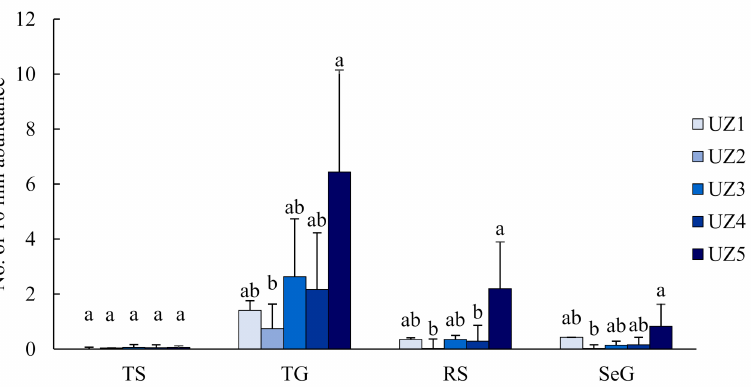
Figure A2. Changes of observed 10-min butterfly abundance in different groups along the urban- isation gradient (UZ1, urban centre; UZ5, urban fringe). Different letters above the bars indicate significant differences at p < 0.05. Table A1. List of the 28 sampling urban parks in the study. Urban zones represent the location of the park (UZ1, urban core; UZ5, urban fringe). Age of park represents greening years since establishment of the park to 2019, and we classified age into three groups: A (less than 11 years), B (11–20 years), C (more than 20 years). PIS represents the proportion of impervious surface within 1 km from the boundary of the parks, and to some extent represented the environment outside the park. DTC represents the distances from park center to urban center point, i.e., Tiananmen Square and DTP represents the minimum distances between adjoining parks. Proportion of sampling area represents the proportion of butterfly surveying area occupied the area of green space within each